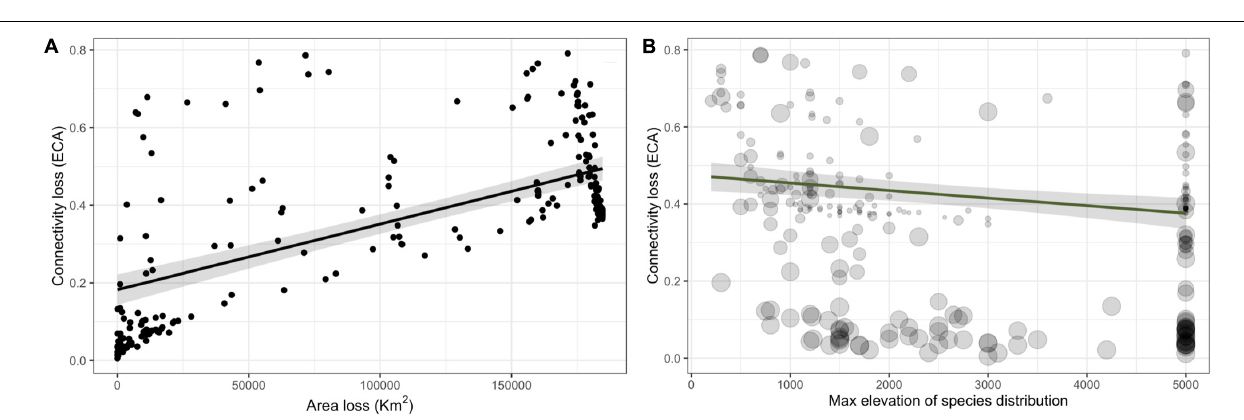
FIGURE 4 | Connectivity loss as a function of area of habitat loss (A) and for and the maximum elevation of the species distribution (B) for 245 forest bird and mammals on Borneo. In (B) point size represents the area loss shown in panel (A)